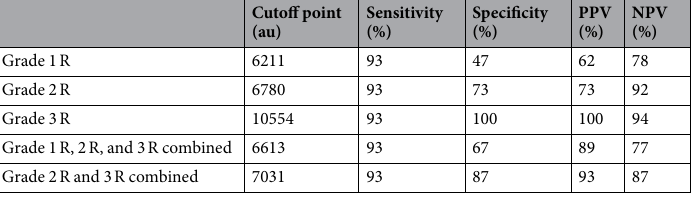
Table 3. Sensitivities, specificities, and predictive values for the diagnosis of cardiac rejection. PPV, positive predictive value; NPV, negative predictive value.